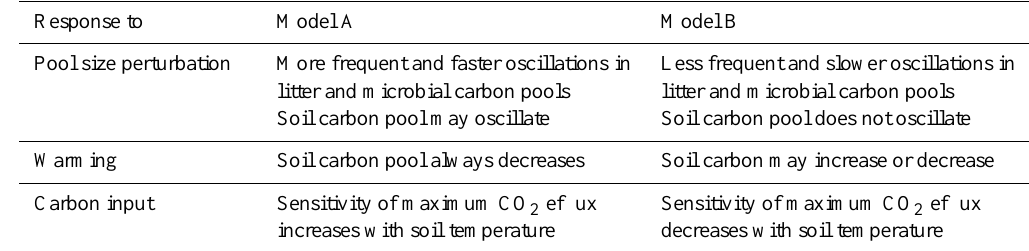
Table 2. Key differences between the two nonlinear soil microbial models. Response